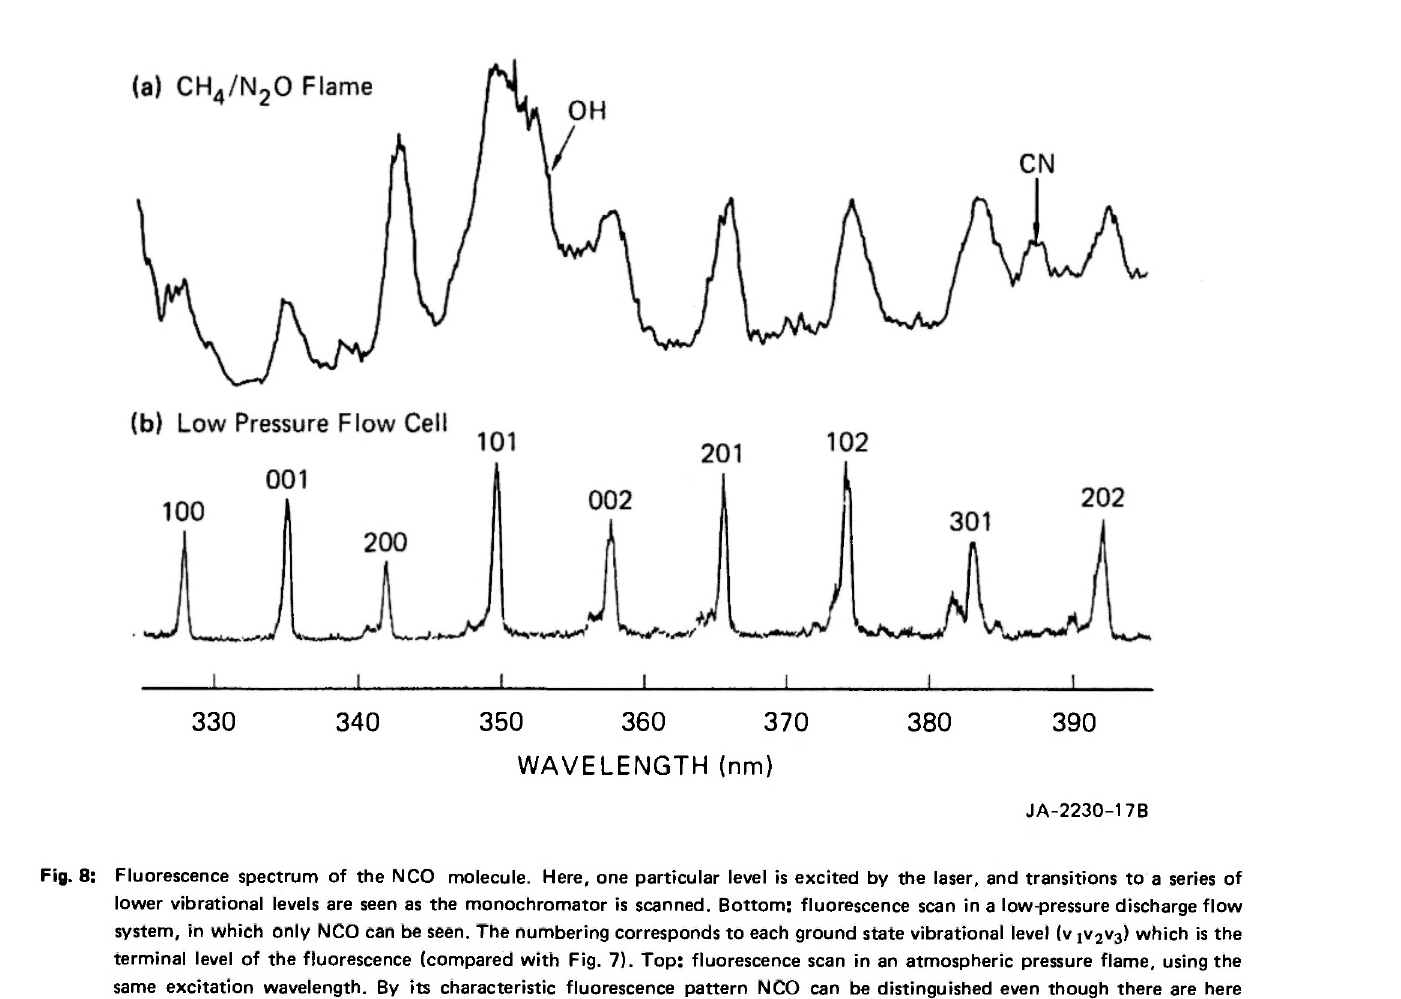
Fig. 8: Fluorescence spectrum of the NCO molecule. Here, one particular level is excited by the laser, and transitions to a series of lower vibrational levels are seen as the monochromator is scanned. Bottom: fluorescence scan in a low-pressure discharge flow system, in which only NCO can be seen. The numbering corresponds to each ground state vibrational level (v iv 2 v 3 ) which is the terminal level of the fluorescence (compared with Fig. 7). Top: fluorescence scan in an atmospheric pressure flame, using the same excitation wavelength. By its characteristic fluorescence pattern NCO can be distinguished even though there are here interferences due to the OH and CN molecules also. The use of the wavelength corresponding to either the 201 or the 102 band appear the best for detecting NCO among these interfering species [Reprinted from Ref. 13 by permission of the Combustion